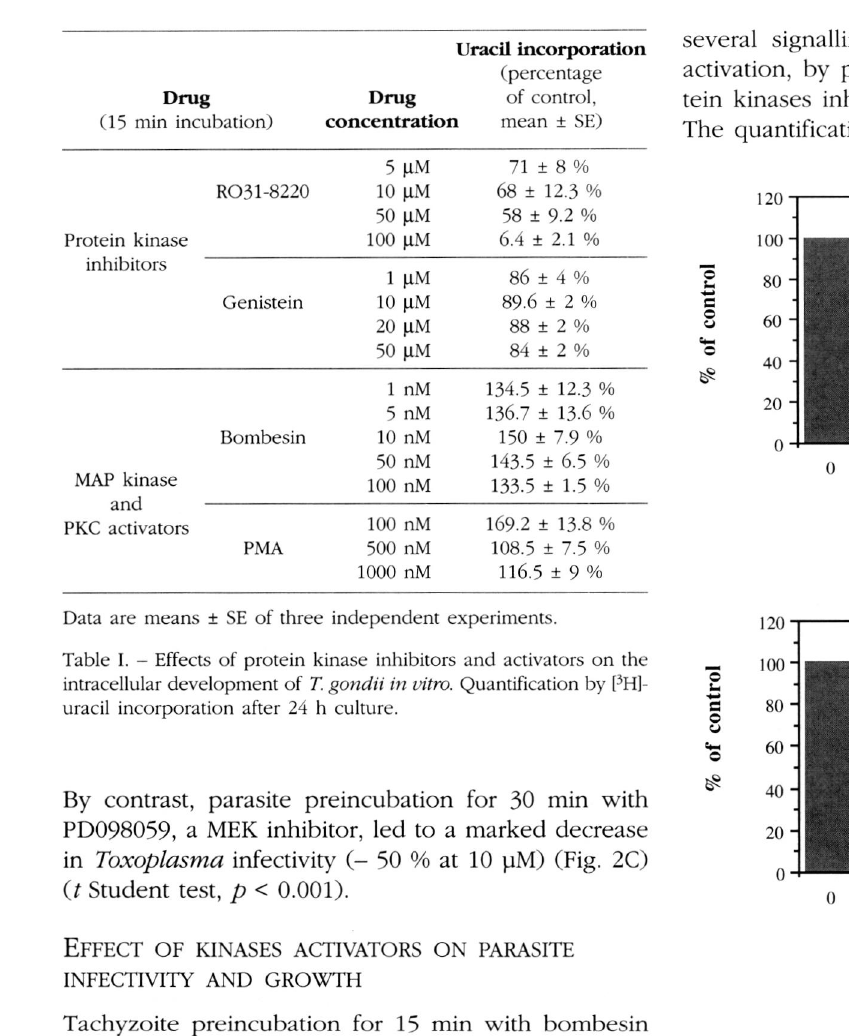
Table I. - Effects of protein kinase inhibitors and activators on the intracellular development of T. gondii in vitro. Quantification by [ 3 H]- uracil incorporation after 24 h culture.